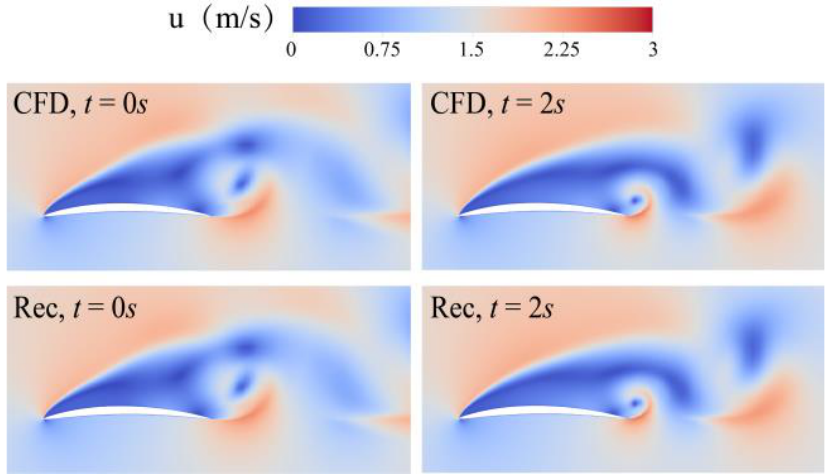
Figure 8. Flow reconstruction of a Teal airfoil.